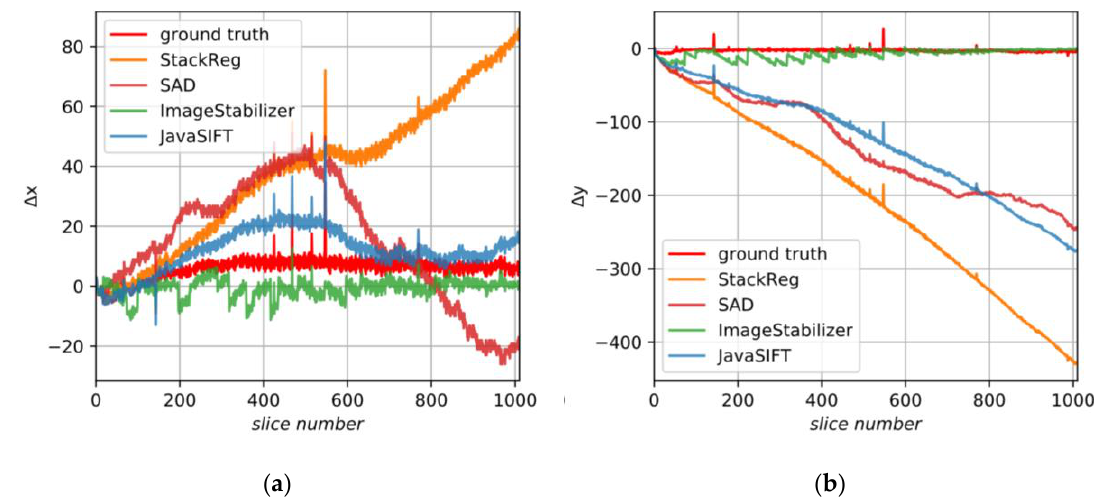
Figure 16. The displacements found by various algorithms for sample B: ( a ) in the X axis; ( b ) in the Y axis.